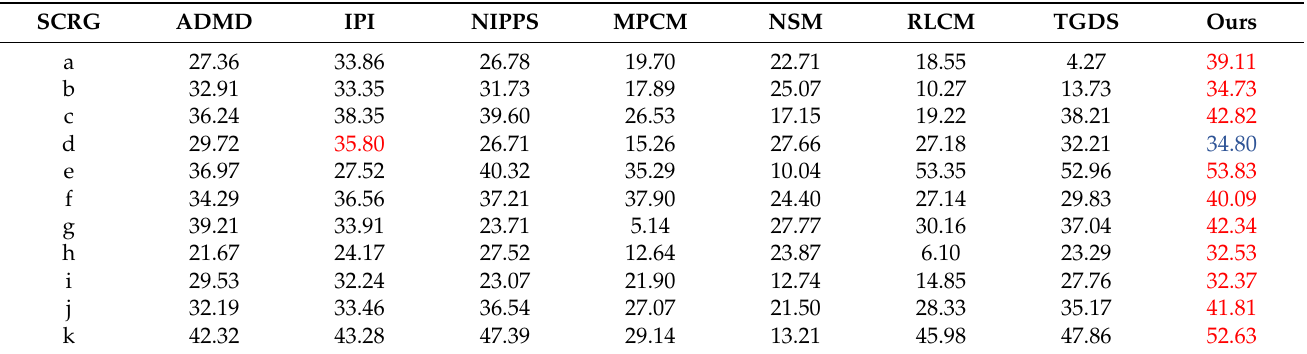
Table 2. SCRG values of different